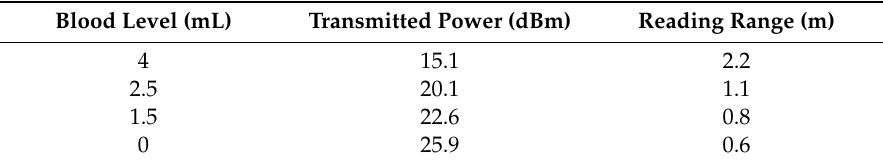
Figure 16. Reading ranges obtained for the proposed tag attached to a clinic tube with different blood volumes. Table 3. Minimum transmitted power required to activate the integrated circuit (IC) chip (NXP UCODE G2XL) and reading ranges of the proposed tag attached to a clinic tube with different blood volumes, measured at the center frequency f c = 867 MHz of the UHF RFID band.